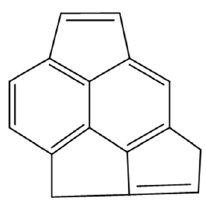
Scheme 1. Example of “light” coke Scheme 1. example of “light” coke molecule.